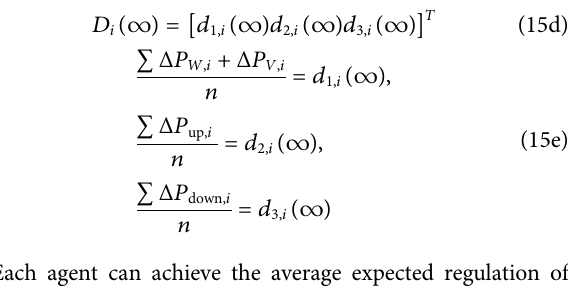
FIGURE 7 | Look-ahead DED performance with prediction